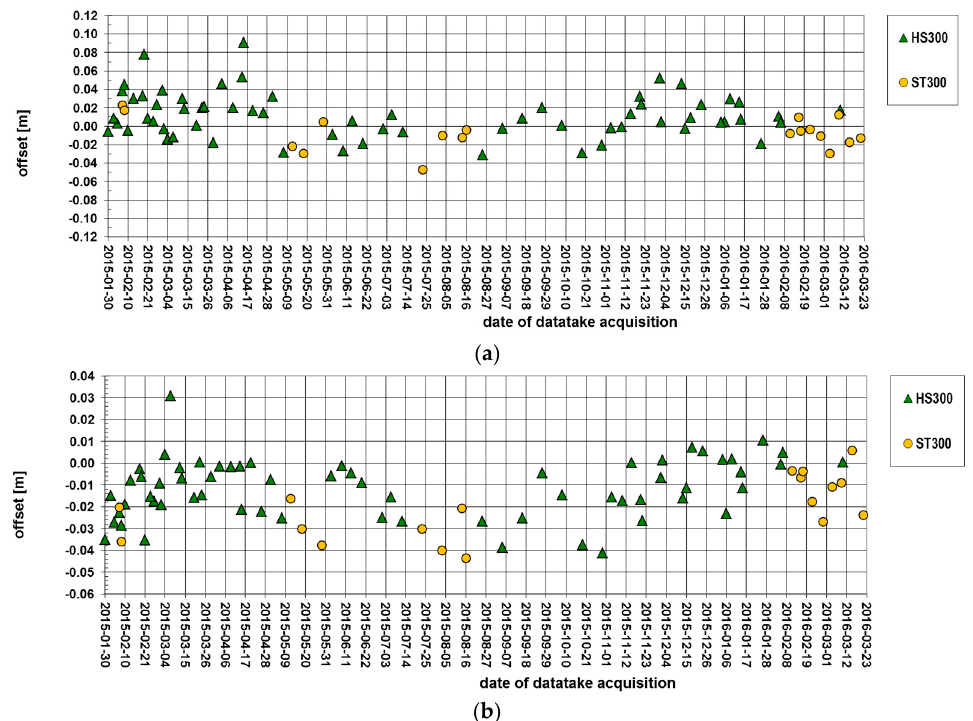
Figure 8. Close-up of the temporal progression of the obtained azimuth ( a ) and range ( b ) offset at the Wettzell test site during the ST300 campaign (yellow) interleaving regular HS300 acquisitions (green).